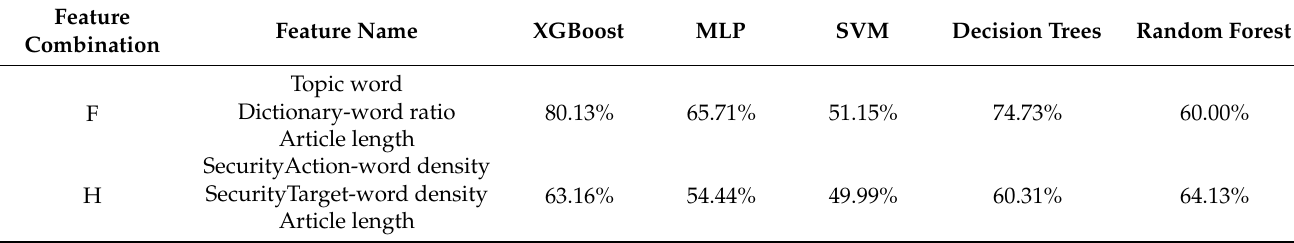
Table 9. Classification accuracy of classifiers with article length as feature.